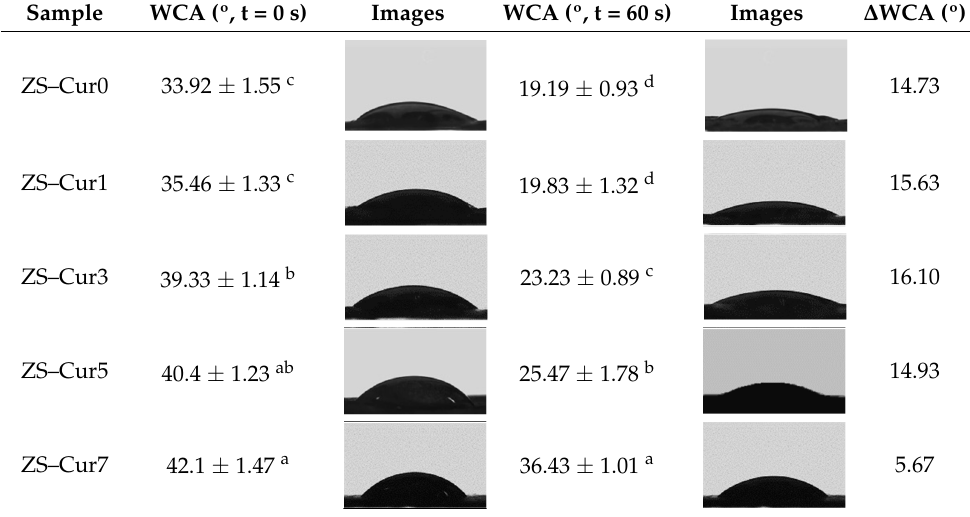
Table 3. Water contact angle of zein/shellac films loaded with curcumin at 0 s and 60 s. Sample WCA (º, t = 0 s)